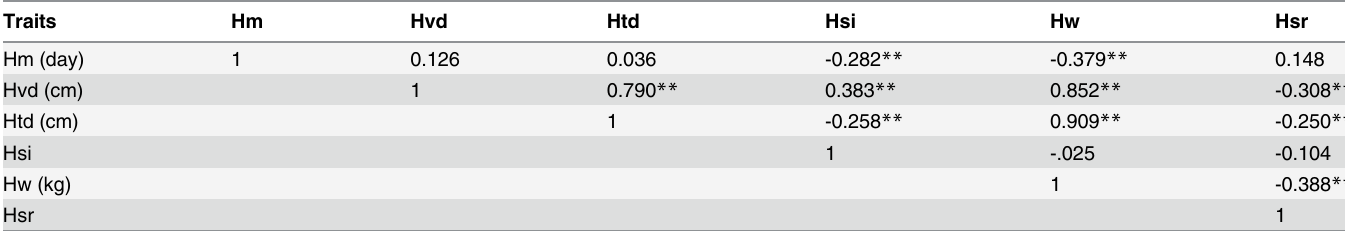
Table 3. Correlation (Pearson) analysis of 6 main head traits in DH population. Traits